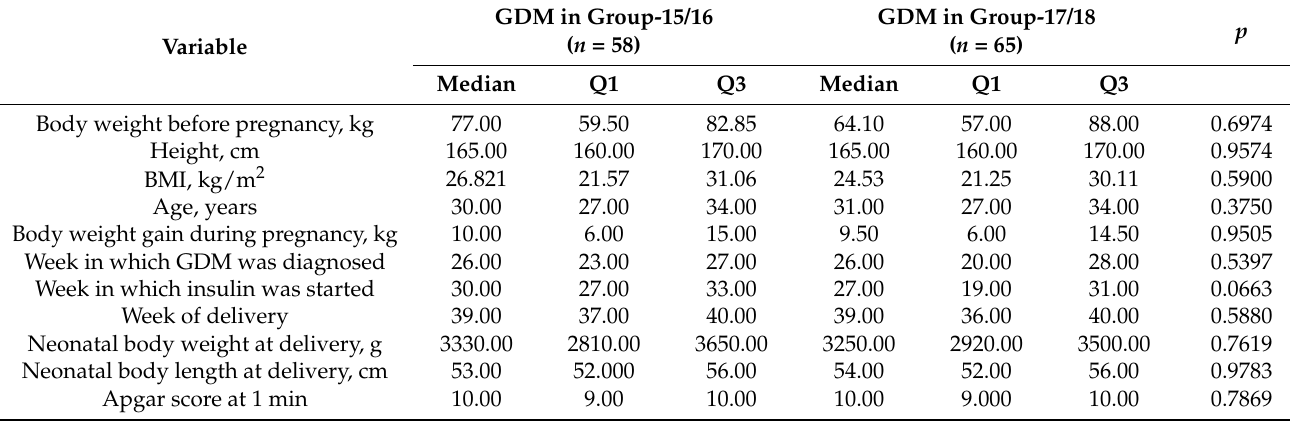
Table 1. Characteristics of the study